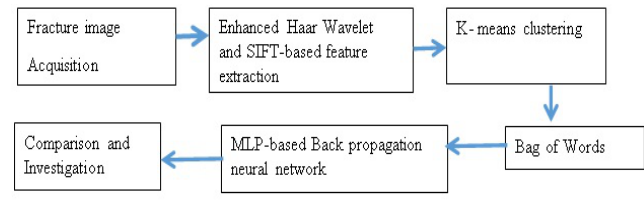
Figure 1. Block diagram of the proposed intelligent fracture detection